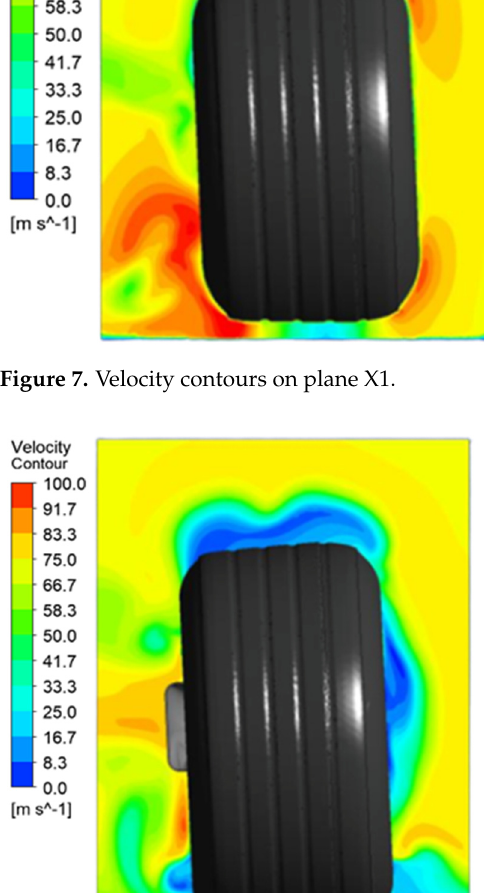
Figure 7. Velocity contours on plane X1.